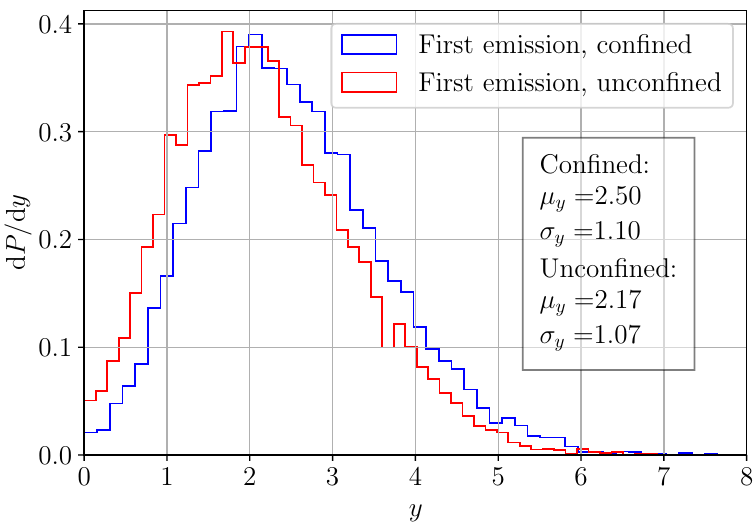
Figure 2. The probability distribution in rapidity for uncon(cid:12)ned (a) and con(cid:12)ned (b) dipole- evolution. The box shows the average and spread of the